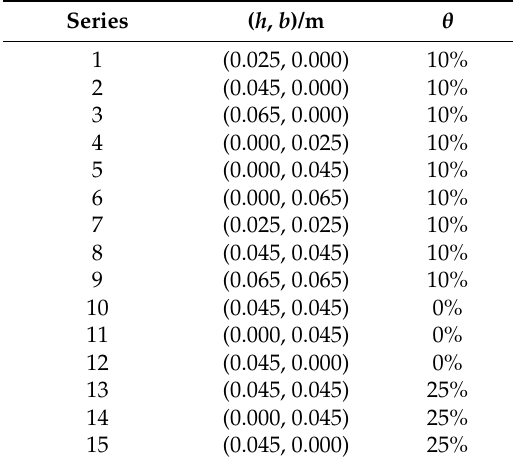
Figure 3. Sketch of the experimental model and test equipment. Table 1. Summary of the operating conditions for the experiments.